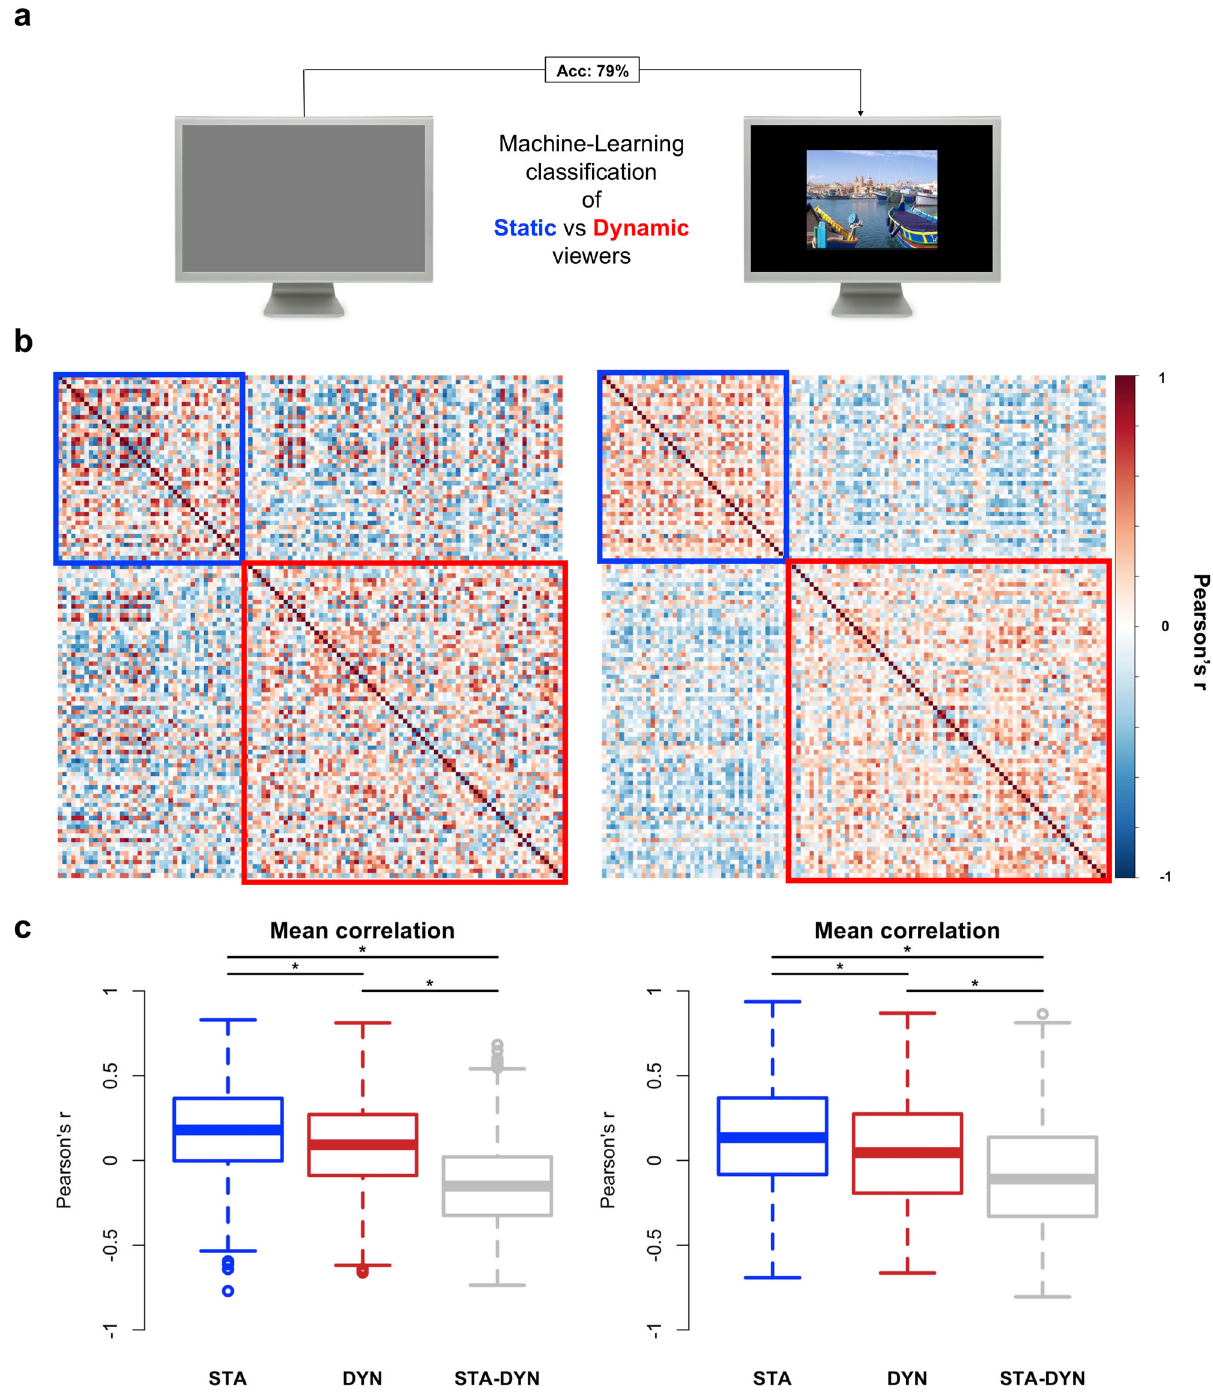
Fig. 7 Subjects similarity in image-viewing and blank screen viewing. a Blank screen viewing eye movement features were extracted and used to predict individual subject labels (Static vs. Dynamic) by means of a random forest classi fi er. The algorithm was trained on features extracted from the blank screen viewing condition and tested on cluster labels extracted while participants were exploring visual scenes, in a cross-classi fi cation design. The model showed 79% accuracy in cluster classi fi cation from blank screen viewing features. b For each pair of subjects a Pearson ’ s r is computed between the vectors of z - scored features extracted from the image-viewing task (right) and the blank screen viewing condition (left). X and Y axes indicate subjects. The colour of each cell indicates the Pearson ’ s correlation value, while the coloured squares indicate the cluster (i.e., the visual exploration style; blue = static viewers; red = dynamic viewers). c Boxplots showing the comparison between the mean correlation within each group (static = STA, n = 42; dynamic = DYN, n = 72) and between groups (STA-DYN). STA = within-group correlation in static viewers; DYN = within-group correlation in Dynamic viewers; STA- DYN: between-groups correlation. * = Bonferroni-corrected signi fi cant difference tested by means of a two-sample